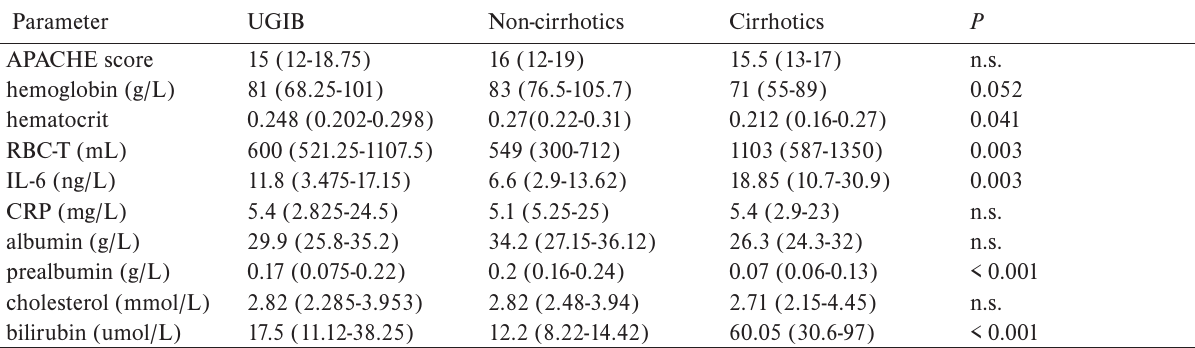
Table 1. Basic metabolic markers in patiens with UGIB (n=35), comparison of both cirhotic (n=14) and non-cirhotic (n=21) subgroups at the start of the